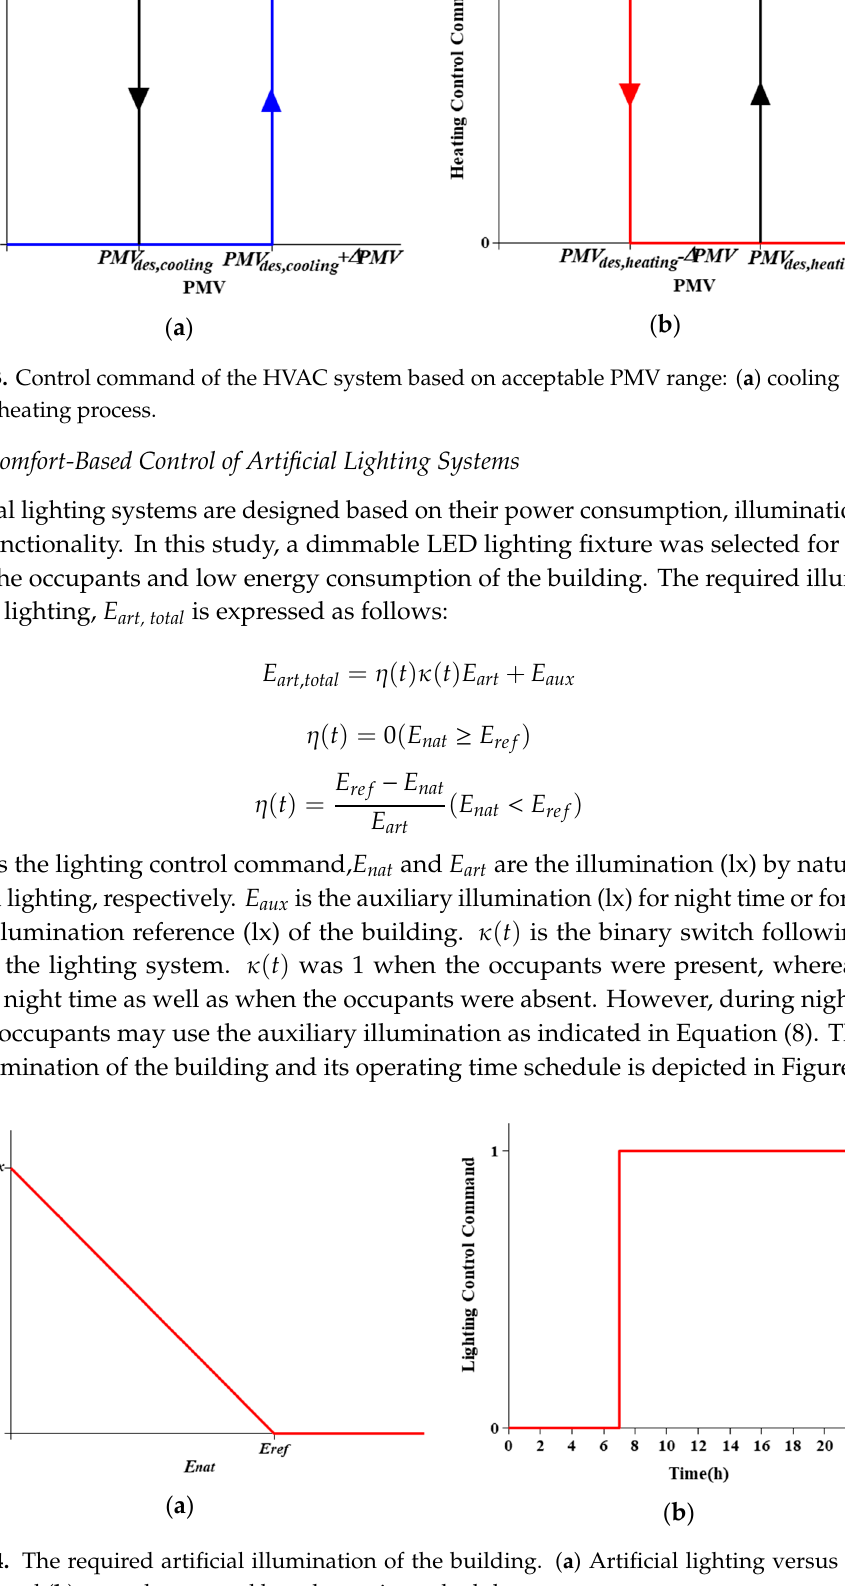
Figure 4. The required artificial illumination of the building. ( a ) Artificial lighting versus natural lighting and ( b ) control command based on a time schedule.